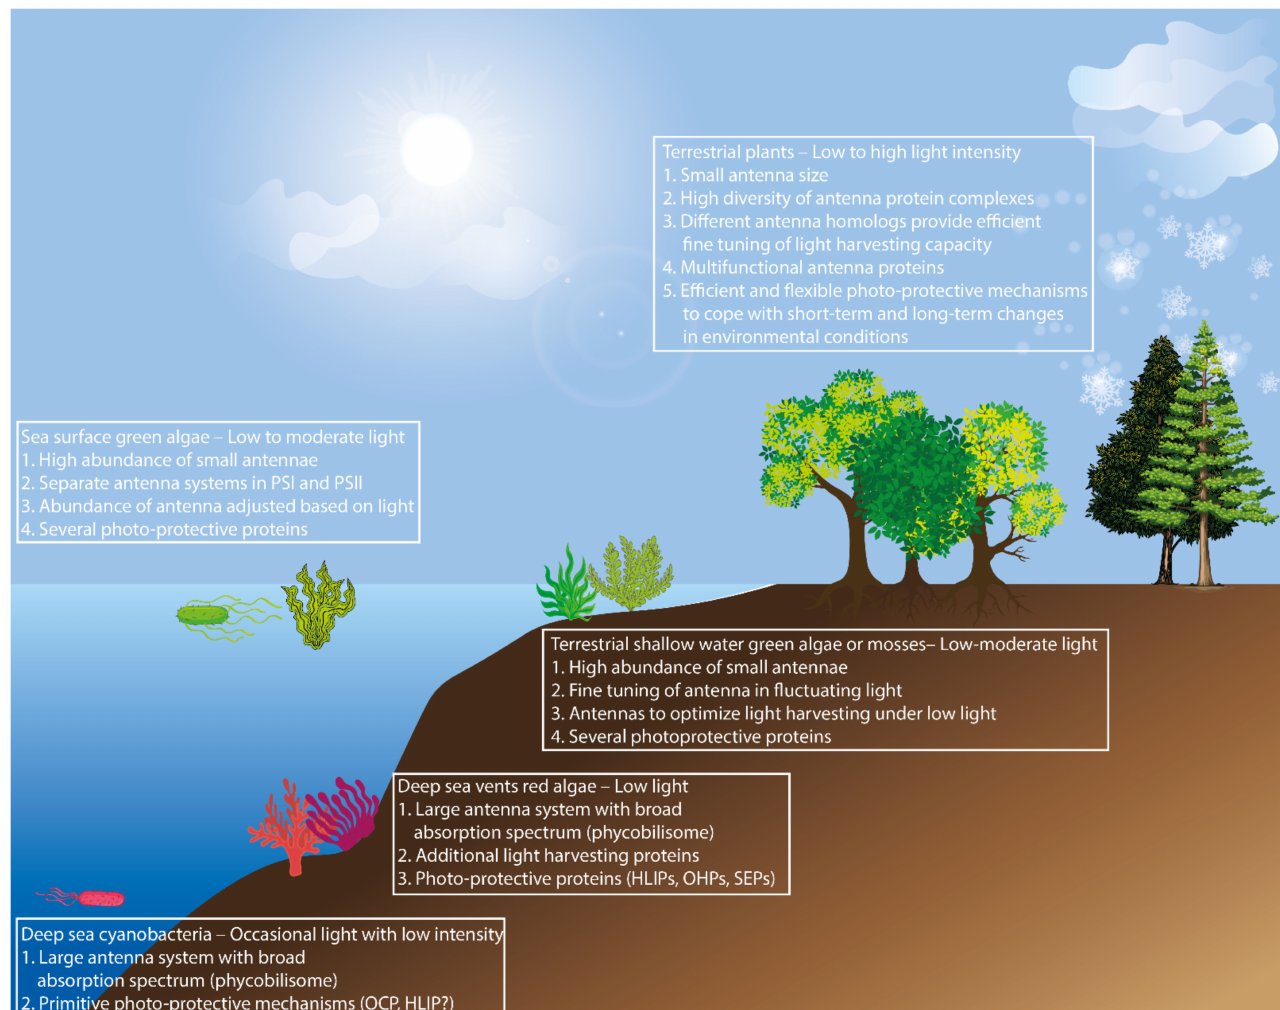
Figure 4. Visual illustration of possible correlation between the evolution and function of light-harvesting antennae and the light environment of the photosynthetic